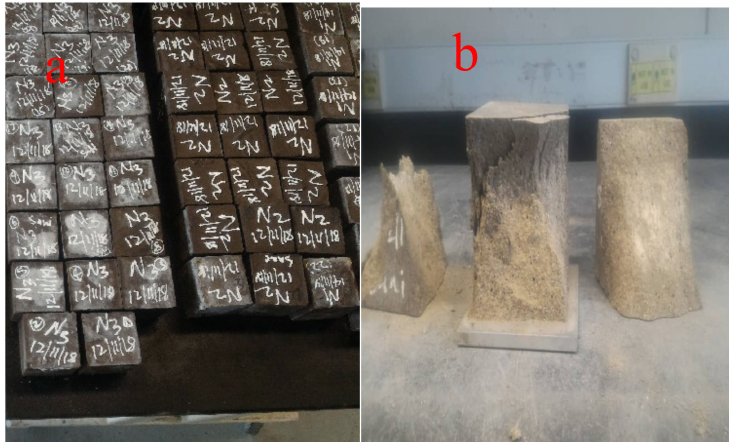
Figure 2. One-part alkali-activated binders ( a ) before test ( b ) after